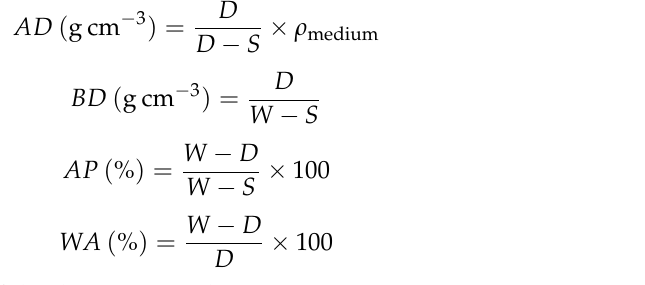
Figure 4. A schematic representation of steps and measurements for density, apparent porosity and water absorption of the composite specimens.